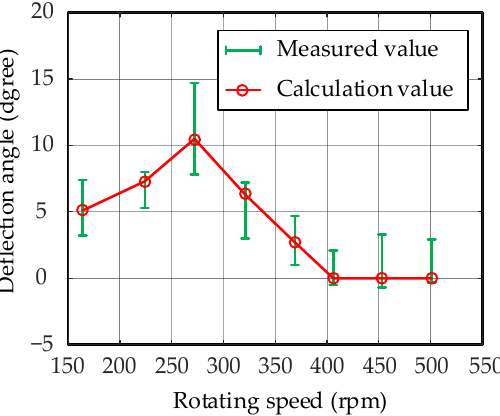
Figure 11. The distribution of circumferential deflection angle of broken particles.